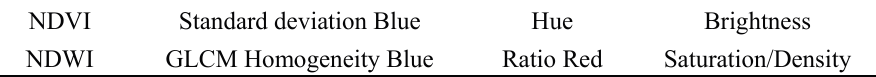
Table 2. Optimum features found by GA-KNN.